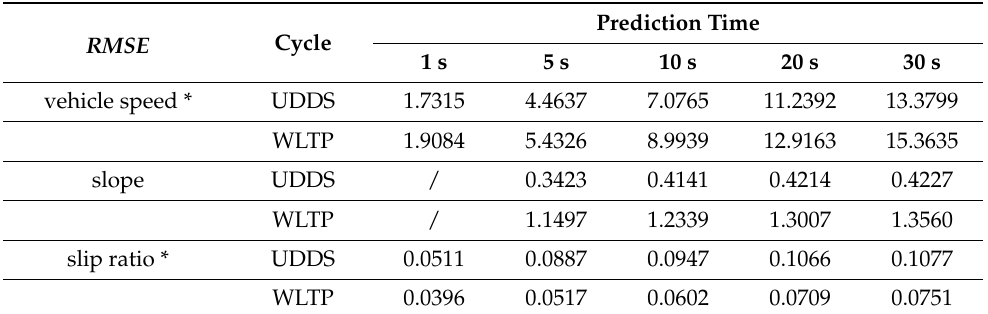
Table 7. Prediction accuracy of each trips’ information at different prediction times under UDDS and WLTC cycles.